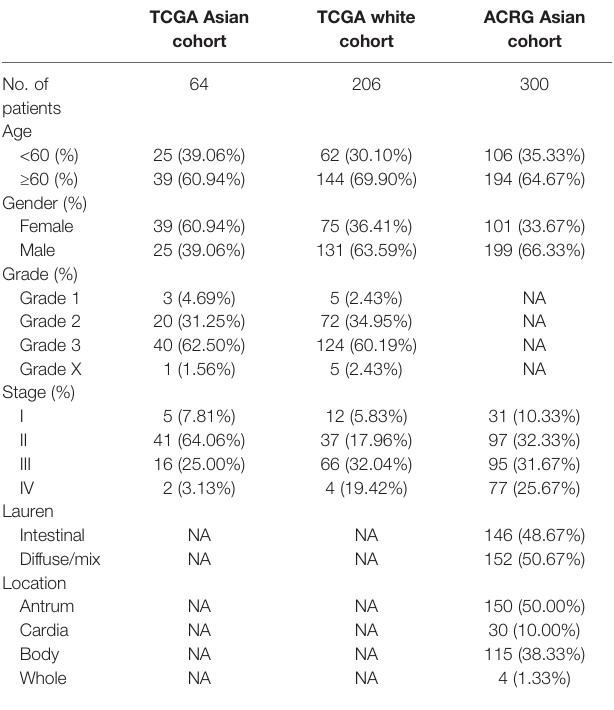
TABLE 1 | Clinical characteristics of the GC patients used in this